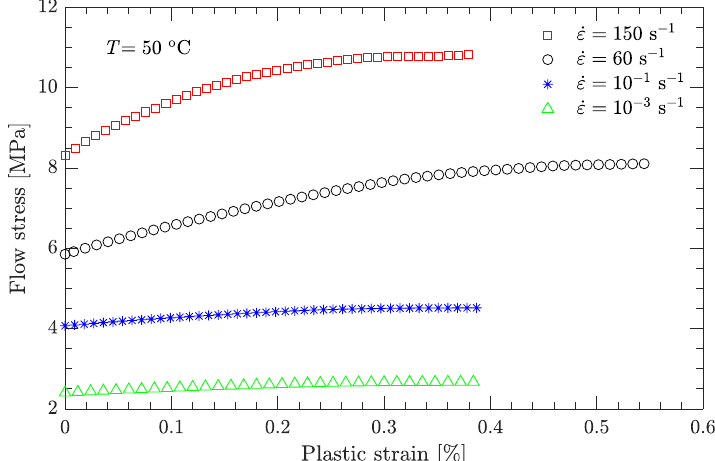
Figure 8. Measured flow stress vs. plastic strain at a temperature of 50 ◦